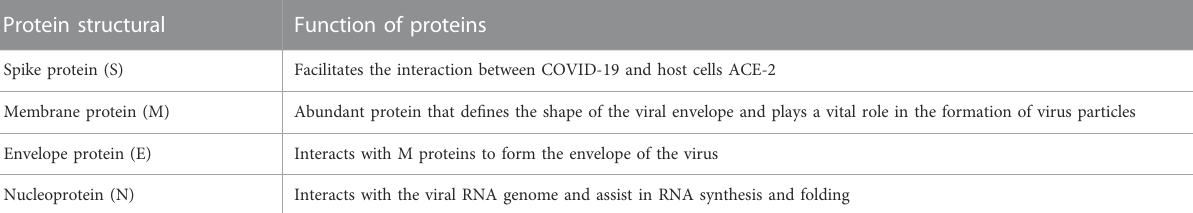
TABLE 1 Structural of SARS/COVID-19. Protein structural Function of proteins Spike protein